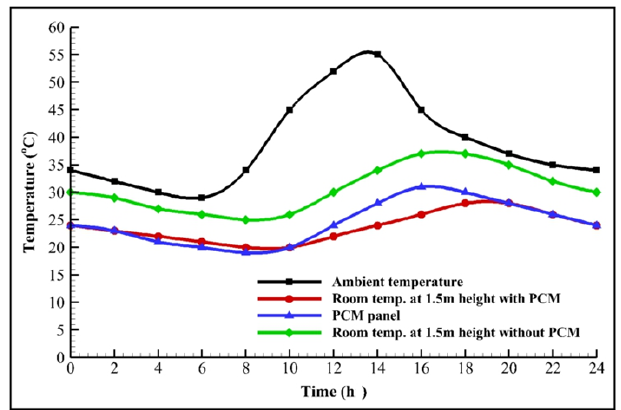
Figure 5 . Temperature variation of the test rooms with and without PCM (REF) at a 1.5 m height in the month of